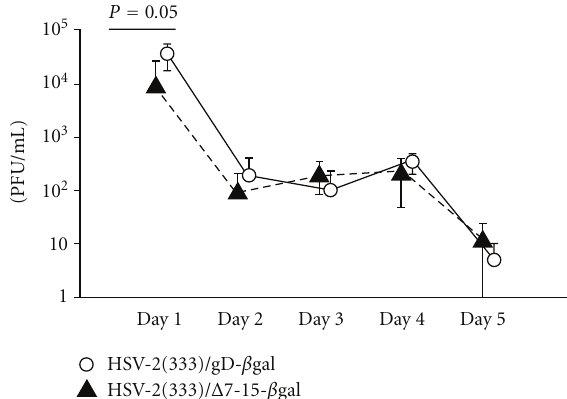
Figure 1: HSV-2 titers in the vaginal tract after infection with the attenuated viruses HSV-2(333)/gD- β gal or HSV-2(333)/ Δ 7-15- β gal are only minimally a ff ected by engagement of HVEM. Viral titers were measured in vaginal secretions on the days indicated after virus inoculation. Five mice per group were inoculated intravaginally with 6 × 10 5 PFU of HSV-2(333)/gD- β gal (open circles) or HSV- 2(333)/ Δ 7-15- β gal (filled triangles). Symbols denote mean titers ( ± standard deviation) for each group. There was a statistically significant di ff erence ( P = 0 . 05) in mean titer on day 1, with approximately 0.5 log lower titer of HSV-2(333)/ Δ 7-15- β gal at this time point. Measured titers were statistically equivalent at subsequent time